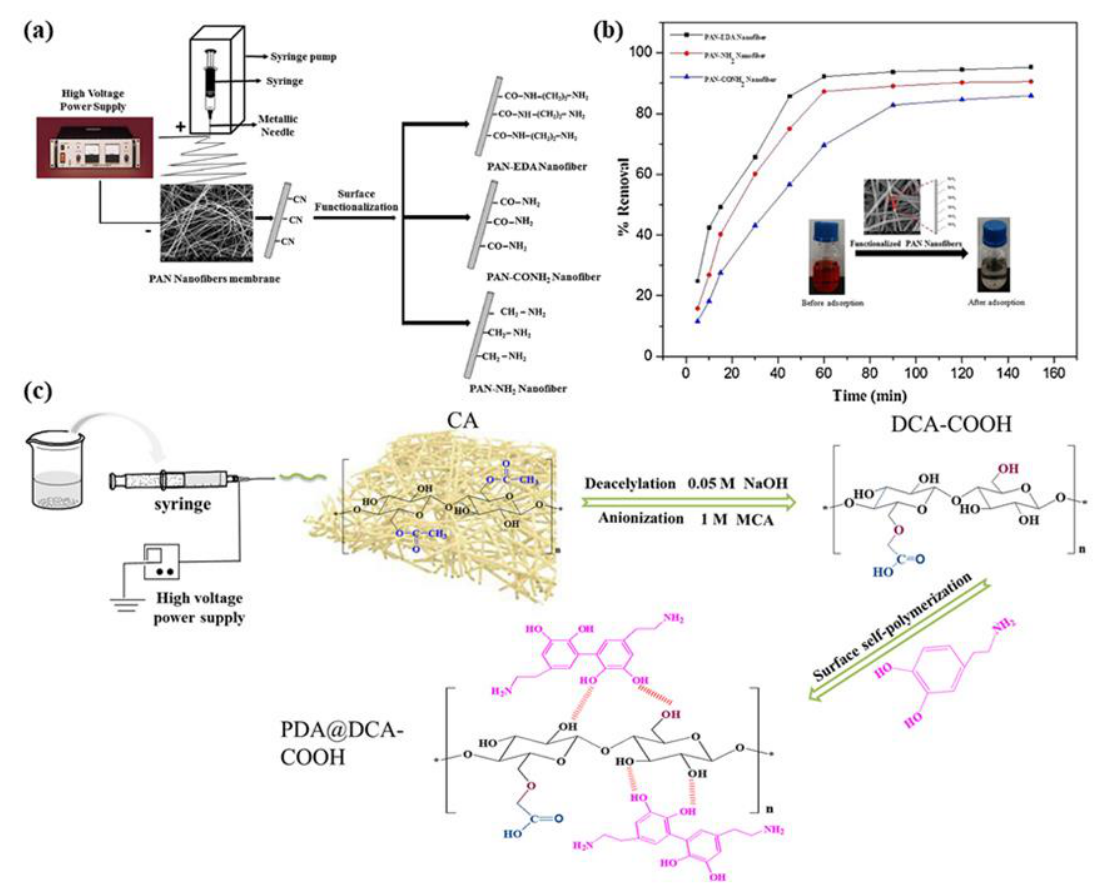
Figure 10. ( a ) Schematic diagram of functionalized PAN nanofibers; ( b ) adsorption of functionalized nanofiber membranes. Reprinted with permission from ref. [105]. Copyright 2018 Elsevier; ( c ) syn-